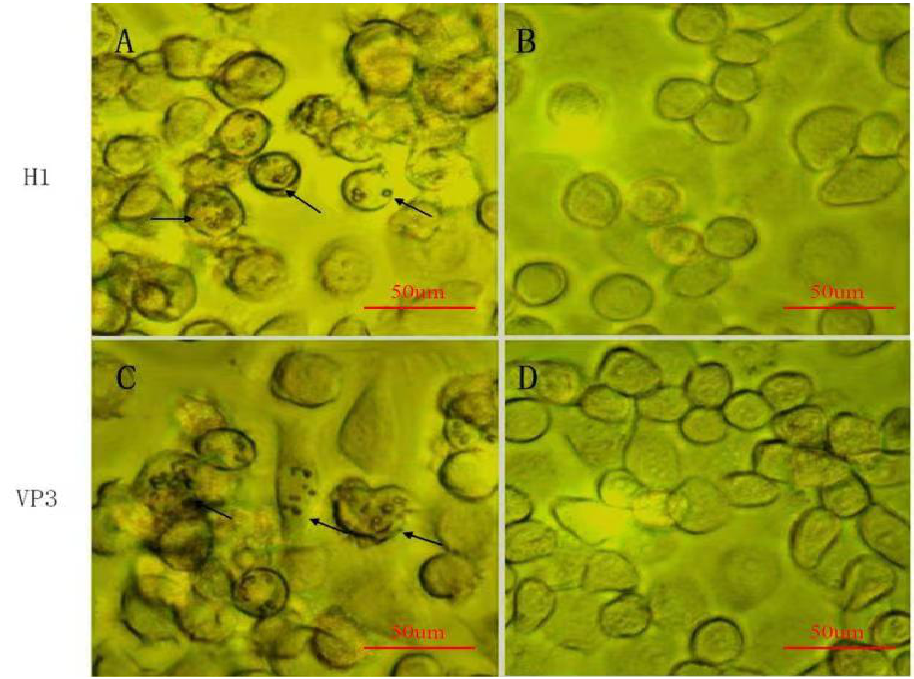
Figure 5. Detection of baculovirus incorporated into BmCPV polyhedra. ( A ) The inoculated BmN cells with BmNPV-H1-D4ORF-polh polyhedra lysis without 0.1% SDS treatment; ( B ) the inoculated BmN cells with BmNPV-H1-D4ORF-polh polyhedra lysis with 0.1% SDS treatment; ( C ) the inoculated BmN cells with BmNPV-D4ORF-VP3-polh polyhedra lysis without 0.1% SDS treatment; ( D ) the inoculated BmN cells with BmNPV-D4ORF-VP3-polh polyhedralysis with 0.1% SDS treatment. H1, BmNPV-H1-D4ORF-polh polyhedra; VP3, BmNPV-D4ORF-VP3-polh polyhedra. The cytoplasmic polyhedra are indicated by an arrowhead.